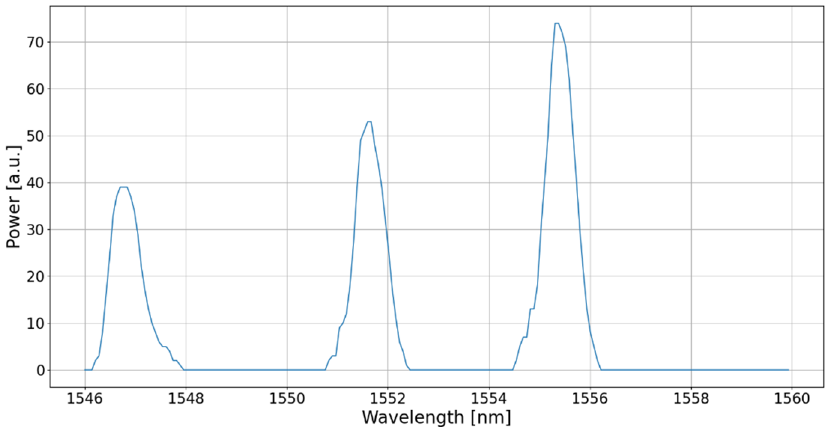
Figure 2 . Reflected amplitude spectrum for three cascaded 1-cm long FBGs measured by the smart interrogator.